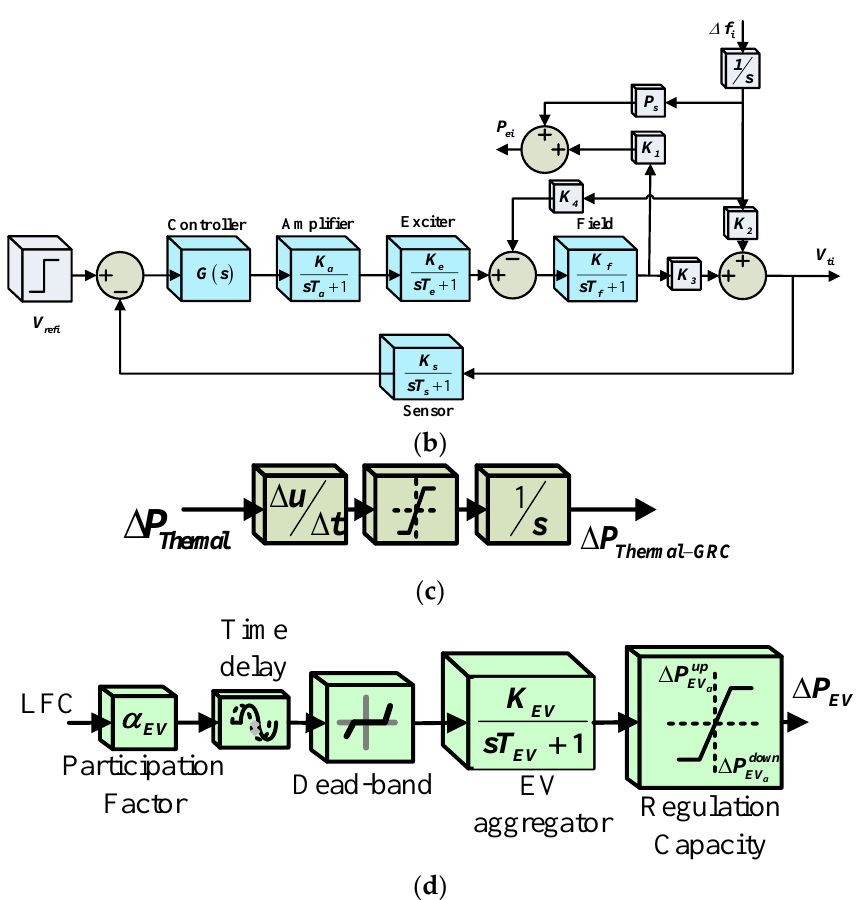
Figure 2. Systems under study: ( a ) interconnected multi-source multi-unit system; ( b ) automatic voltage regulator (AVR) with cross-coupling coefficients; ( c ) GRC nonlinearity; ( d ) electric vehicle (EV) aggregator.